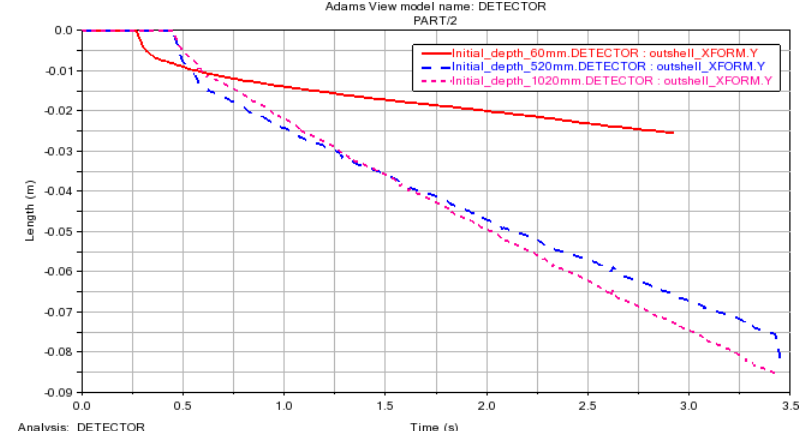
Figure 22. Corresponding displacement curves at different initial depths.